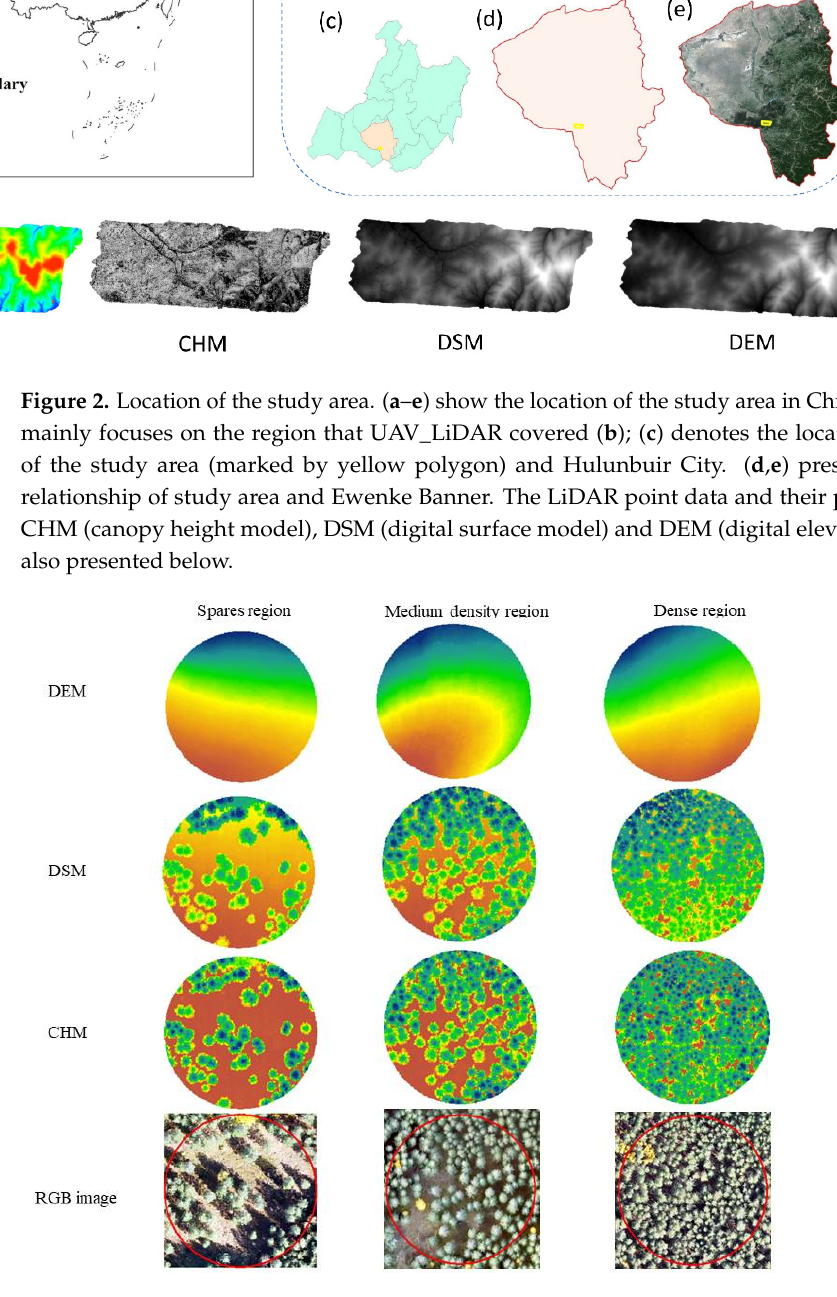
Figure 3. Local maps of DSM, DEM, and CHM data in different density states (taking camphor pine as an example, from left to right, these are sparse area, medium density area, and dense region).